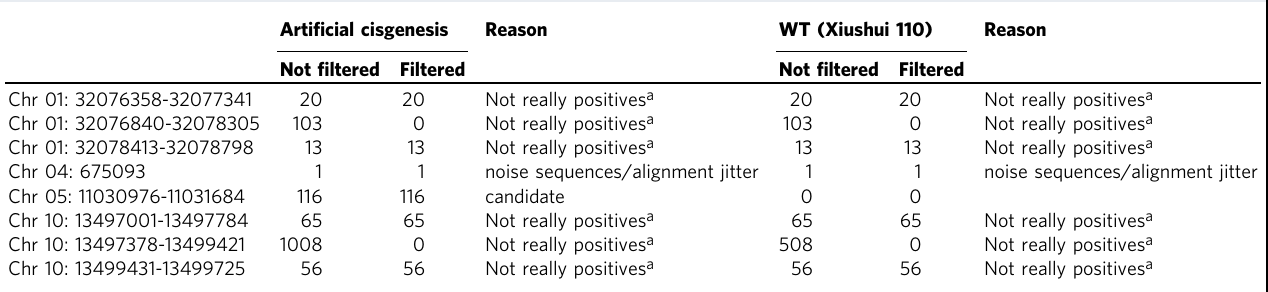
Table 4 Extracted read pairs crossing the Gt1 inserted site derived from original and modi fi ed TranSeq pipeline in arti fi cial cisgenesis rice and